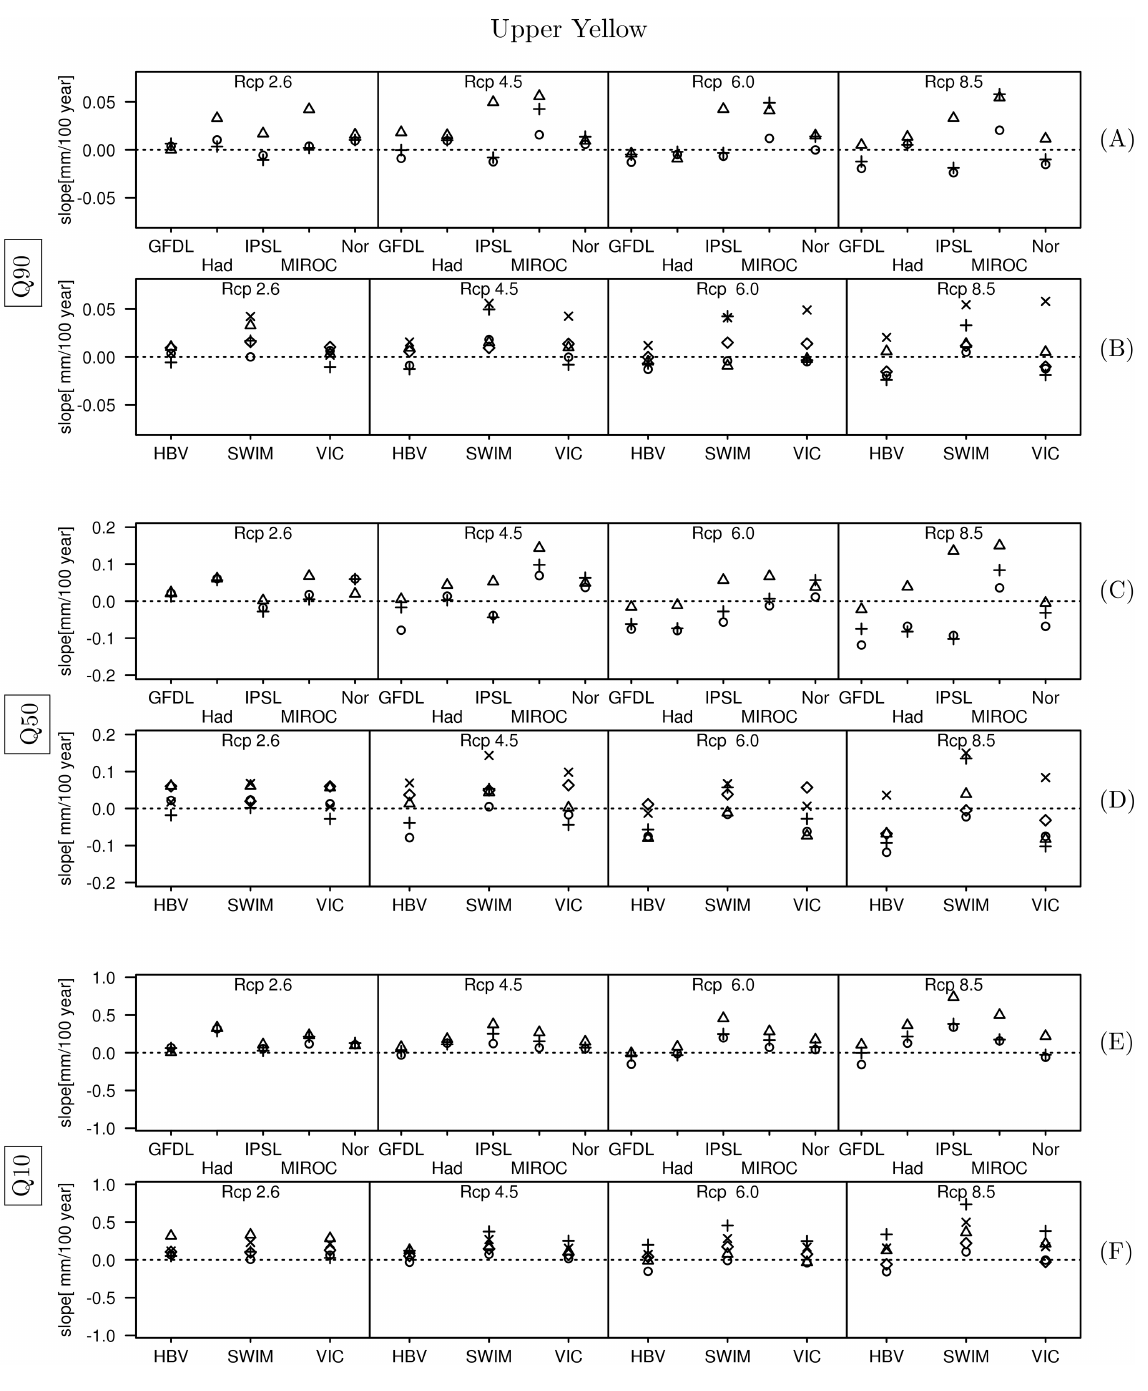
Figure A2. Slopes of trends in (a, b) low-flow percentile Q 90 , (c, d) medium discharge Q 50 and (e, f) high-flow percentile Q 10 grouped by climate models (a, c, e) and by hydrological models (b, d, f) for the Upper